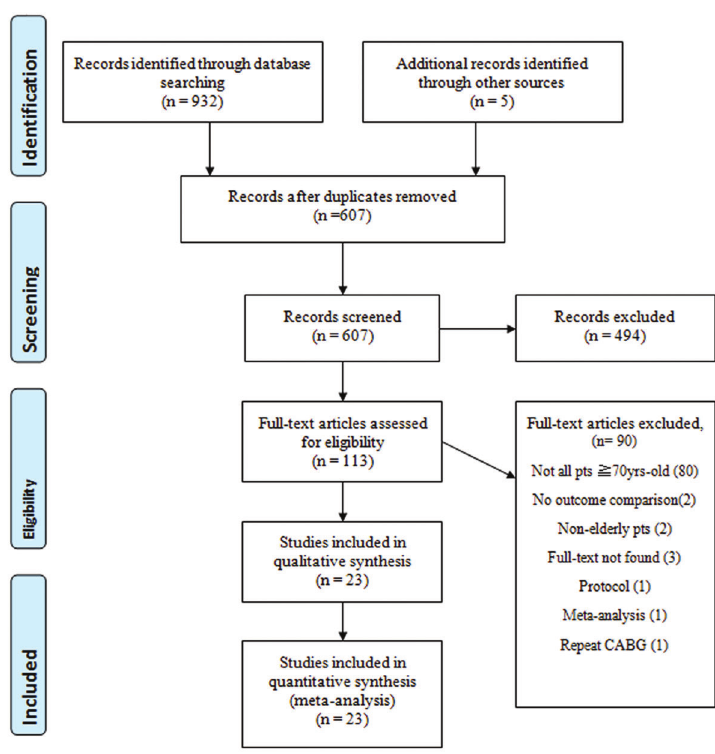
Figure 1. PRISMA fl ow